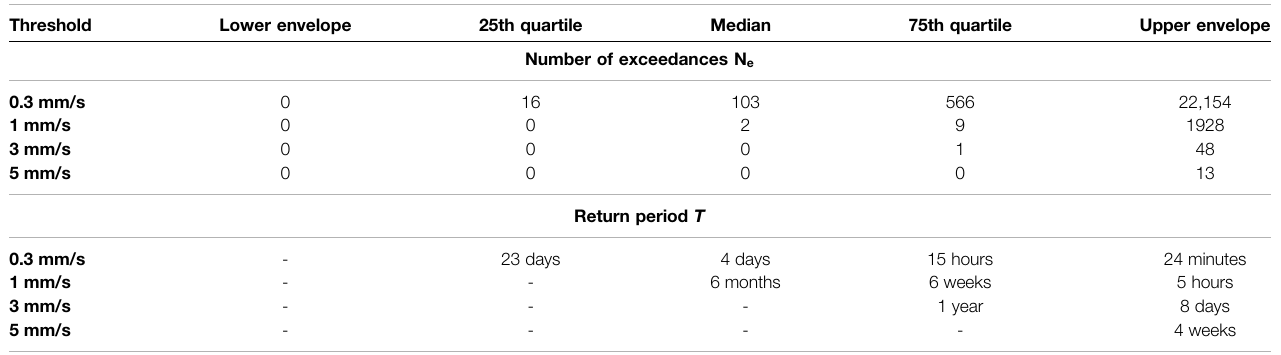
Thespeci fi ednumberofexceedancescorrespondwiththeintersectionsoftheblacklines(thresholds)andredlines(quartiles)in Figure4 .Formostbuildings,thethresholdsforcosmetic building damage (i.e. 1 mm/s, 3 mm/s, and 5 mm/s) were rarely exceeded.